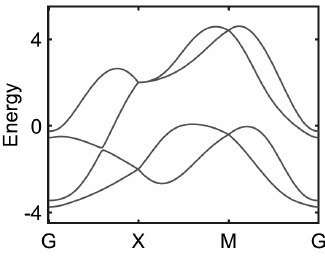
FIG. 2. The band structures correspond to the model Hamil- tonian H 0 in Eq. (9). G , X , and M are the high-symmetry points shown in Fig. 1(b). The parameters are chosen